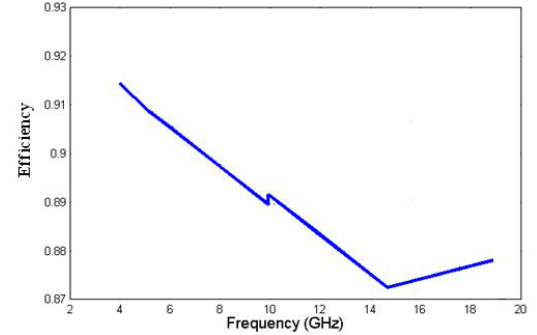
Figure 5: Total eflciency Vs Frequency.